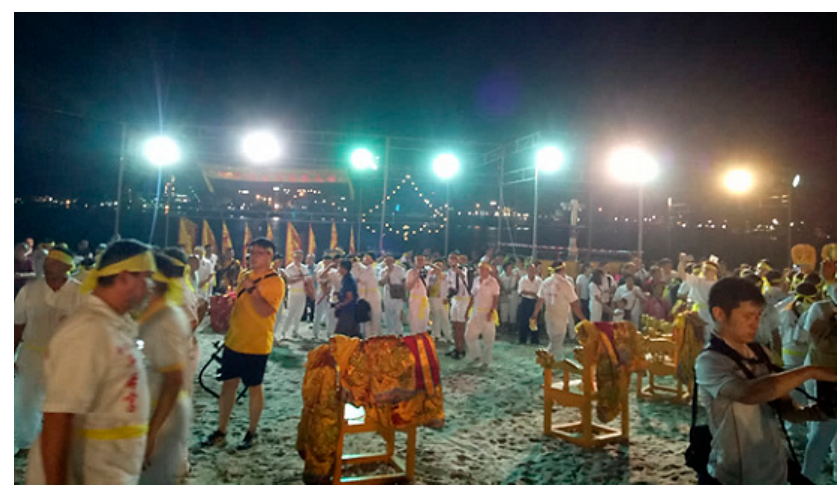
Figure 5. Devotees await the arrival of the spirit mediums for the Qingshui ritual 9 .